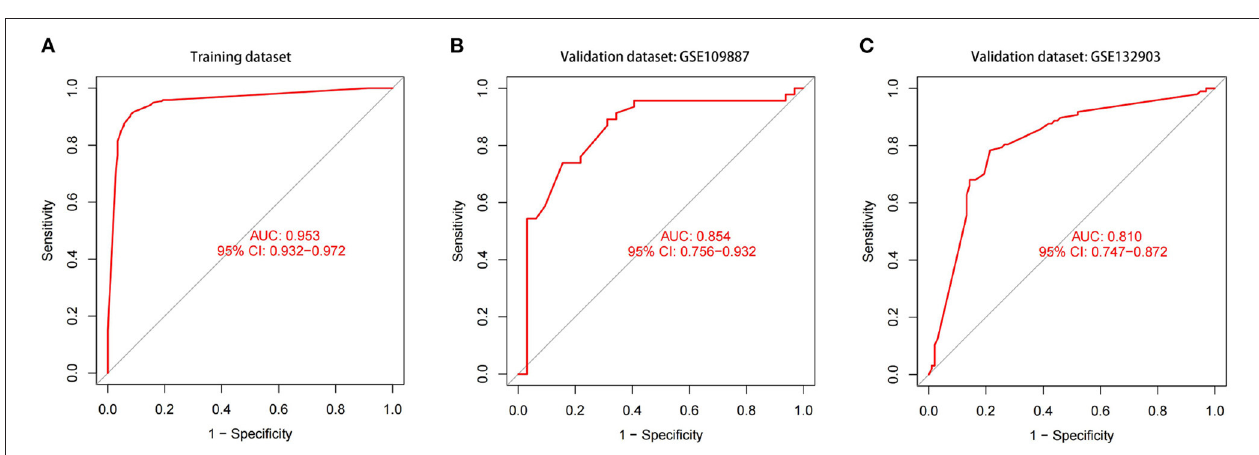
FIGURE 7 | The ROC curves and their respective AUC values are utilized to evaluate the performance of the ANN model in training and validation datasets. (A) GSE5281 and GSE44771 datasets. (B) GSE109887 dataset. (C) GSE132903